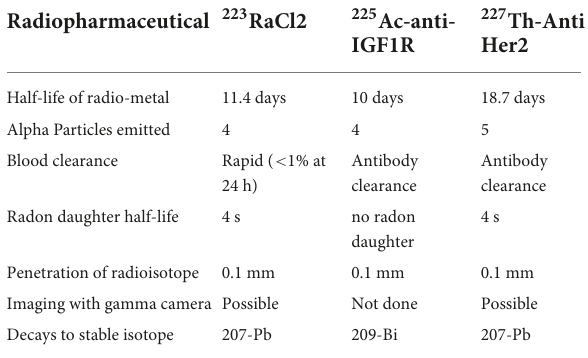
TABLE 1 Alpha emitters for